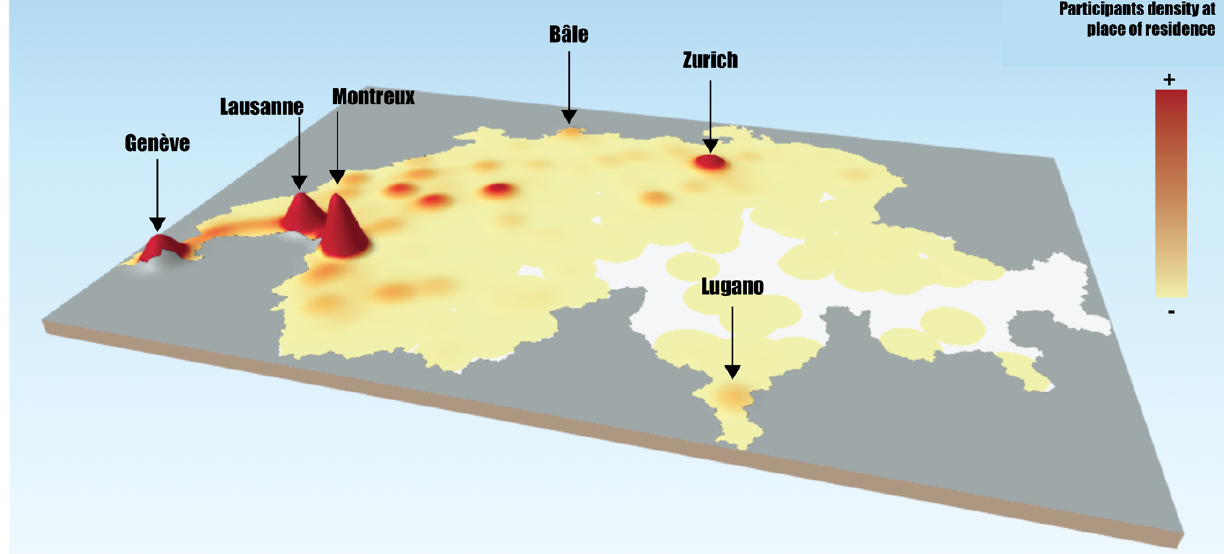
Figure 3. Three-dimensional visualisation of the density of participants by their place of origin. Source: Drevon et al.